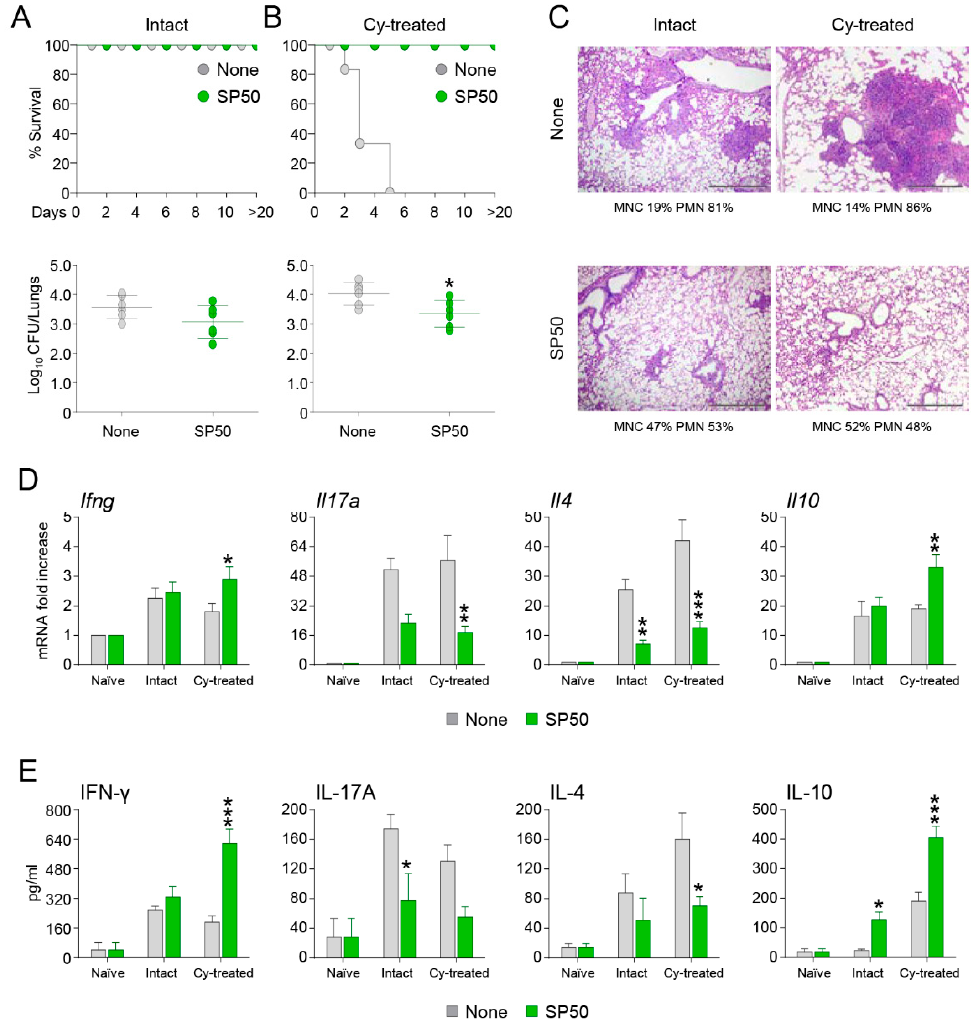
Figure 2. SP50 protects mice from lethal intranasal A. fumigatus infection. Intact ( A ) or ( B ) cyclophosphamide (Cy)-treated mice (150 mg/kg a day before infection) received intranasally 2 × 10 7 A. fumigatus conidia. Mice were treated with SP50 (5 µ g/mouse/i.n.) in concomitance with Aspergillus infection. Mice were assessed for survival, and for fungal growth (Log10 CFU) in the lungs at 3 days post-infection. In ( C ) lung histology (periodic acid-Schiff staining) of A. fumigatus -infected and SP50-treated mice is shown. Values represent percentages of polymorphonuclear (PMN) or mononuclear (MNC) cells in the BAL fluid. ( D ) Gene expression analysis for Ifng , Il17a , Il4 , and Il10 in lungs was done by RT-PCR 3 days after the infection. ( E ) Cytokines were determined in lung homogenates 3 days after the infection by ELISA. Data are pooled from three independent experiments. *, p <0.05, **, p <0.01, ***, p <0.001, SP50 ‐ treated vs SP50 ‐ untreated (None) mice.